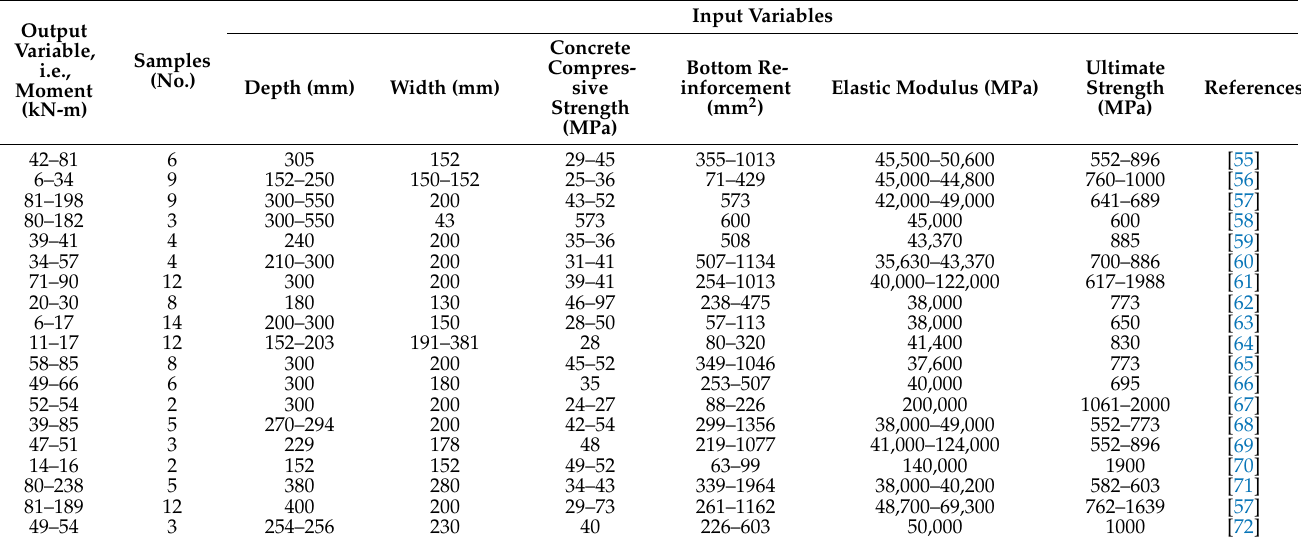
Table 1. Summary of input and output characteristics utilized in the model formulation using ANN and RF regression.